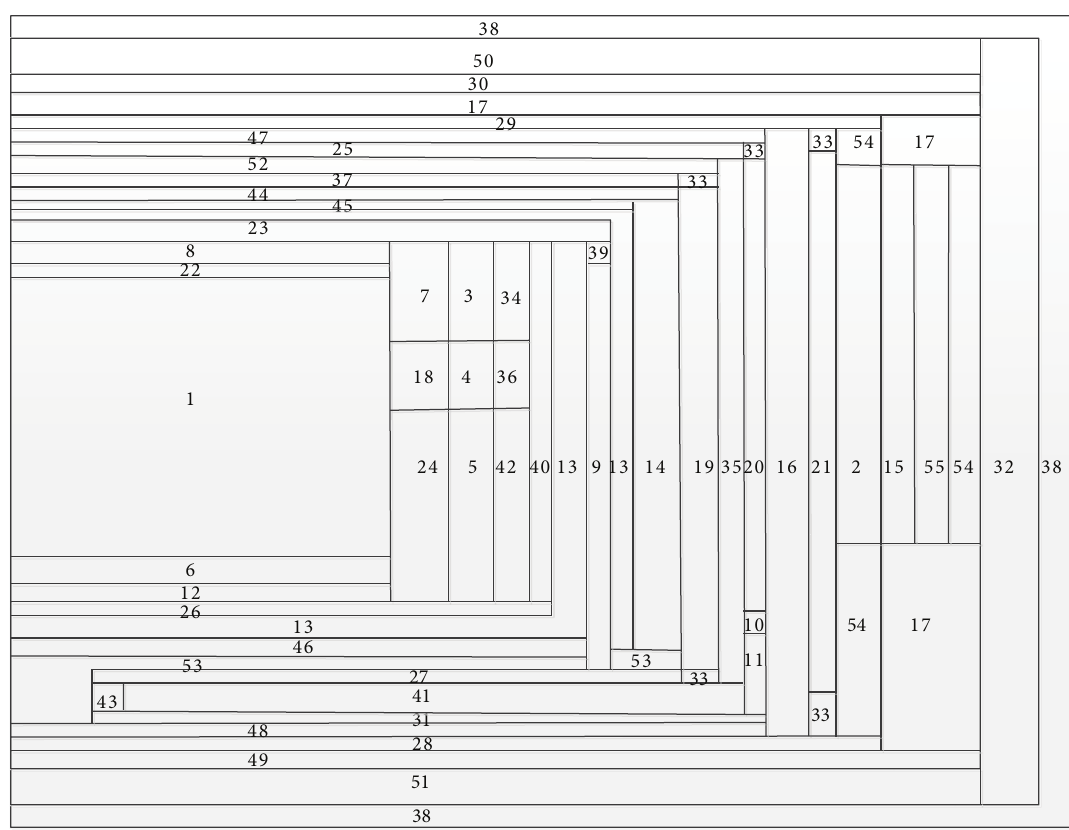
Figure 3: TINTE model of the HTR-PM. (1) Core; (2) water panel; (3–5) control rod channel; (6 and 12) bottom reflector; (7, 13, 18, 24, 34, 36, and 42) side reflector; (8) top reflector; (9) coolant channel; (10 and 11) core inlet cavity; (14, 45, and 46) carbon brick; (15, 21, 28–30, and 54) air gap; (16, 47, and 48) reactor pressure vessel; (17 and 49) thermal insulation; (19, 20, 25, and 37) helium gap; (22) core top cavity; (23) cold helium plenum; (26) hot helium plenum; (27) core bottom cavity; (31) RPV bottom cavity; (32, 50, and 51) concrete; (35, 41, 44, 52, and 53) core barrel and metal internals; (38) air boundary; (39) throttle; (40) leakage flow; (43) flow passage; (55) metallic plate.